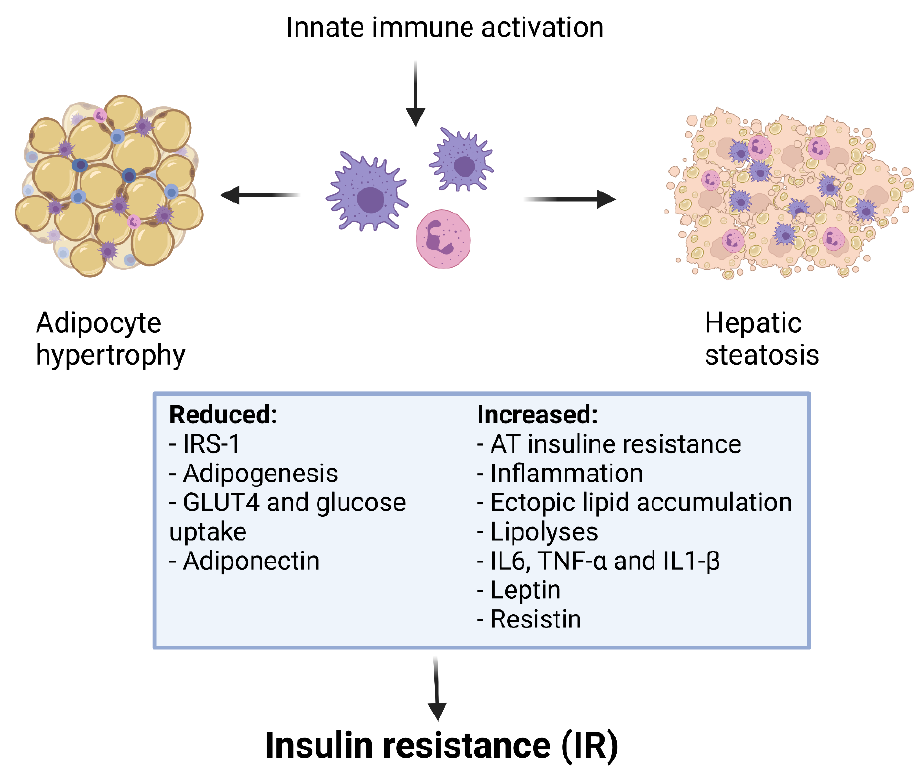
Figure 3. Obesity, inflammation and insulin resistance.